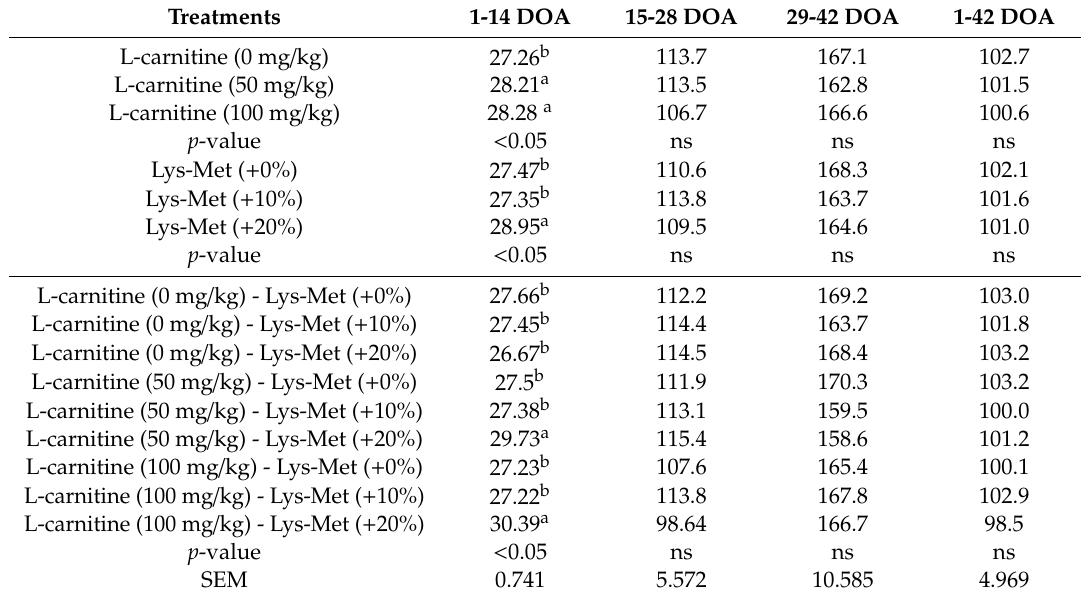
Means within each column of dietary treatments with no common superscript di ff er significantly; DOA: days of age; ns: not significant; SEM: standard error of the means. a–c: means within column di ff er significantly ( p < 0.05). Table 4. Average feed intake (g / day) of broilers fed di ff erent levels of L-carnitine and lysine-methionine